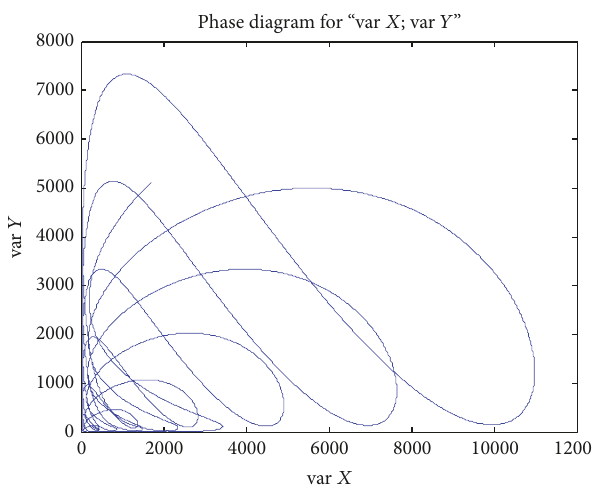
Figure 7: Phase-plane trajectory for variances {𝑞 11 (𝑡),𝑞 22 (𝑡)}